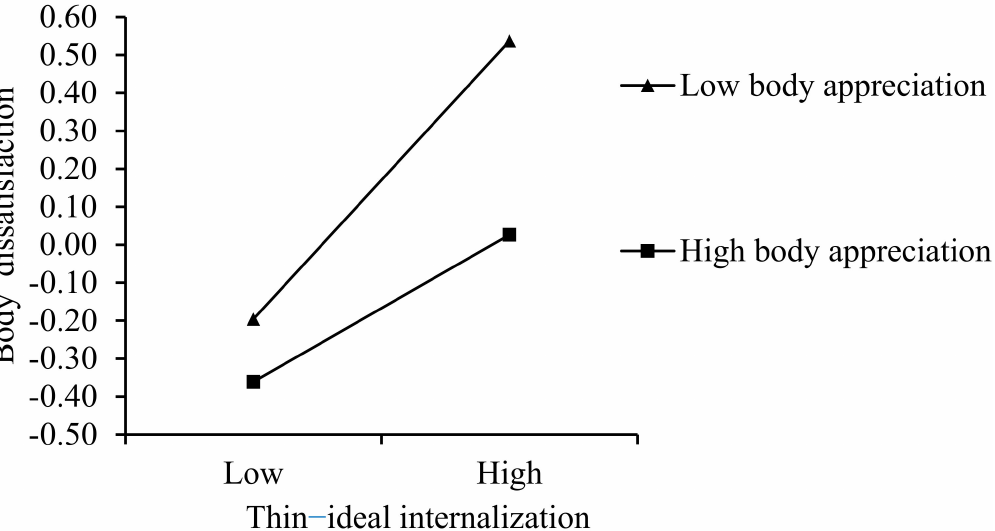
Figure 3. Body appreciation moderated the relationship between thin-ideal internalization and body